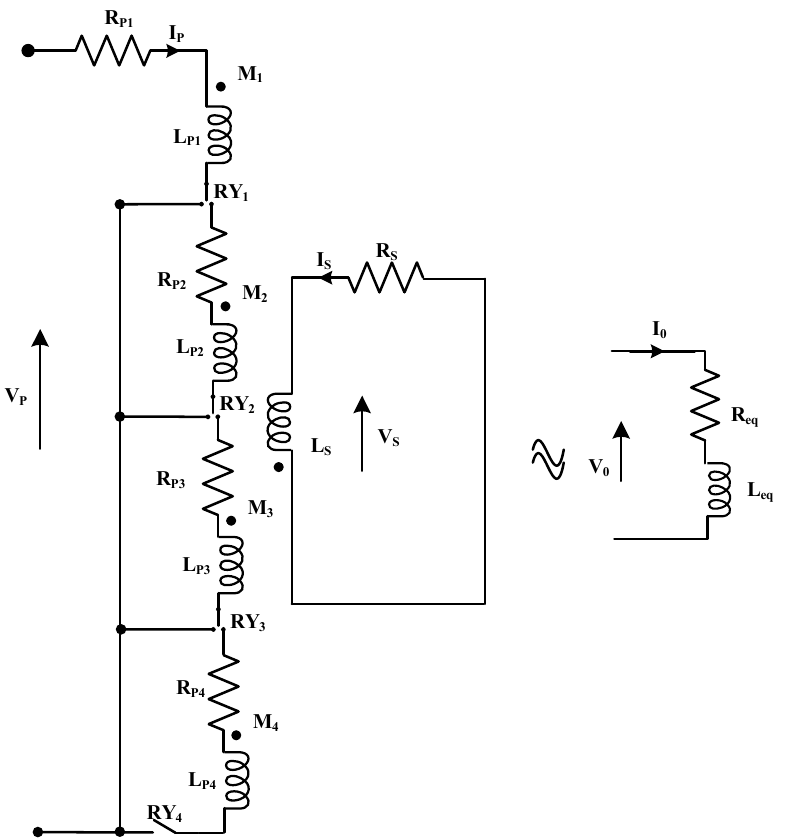
Figure 1. Proposed control methodology. Figure 1 . Proposed control methodology For the coil tapped at 25% of the total coil size and the load (pan/vessel) diameter corresponding to this coil size, the primary coil’s self-inductance is L P1 , the transformer’s mutual inductance is M 1 , while the load resistance is R S and the coil resistance is R P1 . I P represents the work coil current and I S indicates the load current. The IH load equivalent circuit’s KVL voltage equation is provided by Equations (1) and (2), whereas Equation (3) provides the expression for angular